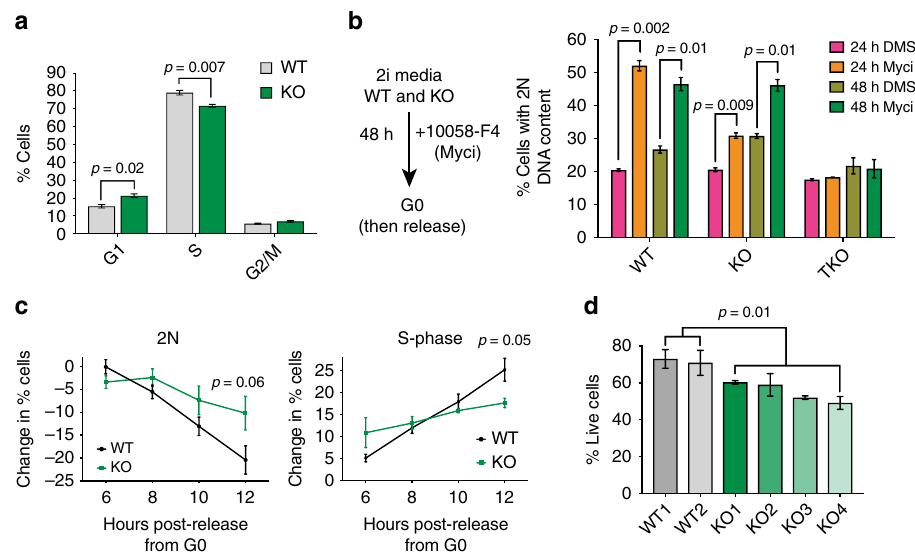
Fig. 2 E2F4 mutant mouse ES cells are defective for cell cycle and cell survival. a Quanti fi cation of the percentage of cells in G1, S, and G2/M phases based on BrdU/PI FACS analysis (unpaired t -test; n = 2 biological replicates with 2 wild-type (WT) and 4 E2F4KO (KO) clones), performed after 4 days of low density plating. b Schematic of synchronizing mESCs in G0 using the Myc inhibitor (Myci) 10085-F4 (left), and quanti fi cation of the percentage of cells in G0/G1 in WT, E2F4KO (KO), and RB family triple knockout (TKO) populations at 24 and 48h of treatment (unpaired t -test; n = 2 – 3 biological replicates with 2 clones of each genotype). c Quanti fi cation of the percentage of arrested and cycling cells post-release from Myci. Cell cycle structure was measured with BrdU/PI staining 6, 8, 10, and 12h after withdrawal of Myci from the media (unpaired t-test was performed with all individual data points from n = 3 – 4 biological replicates with 1 – 2 clones of each genotype). d Quanti fi cation of the percentage of AnnexinVneg/PIneg cells (live cells) in WT and E2F4KO populations 4 days after low density plating (unpaired t -test; n = 3 biological replicates per clone). Data shown as the mean and standard error of the mean